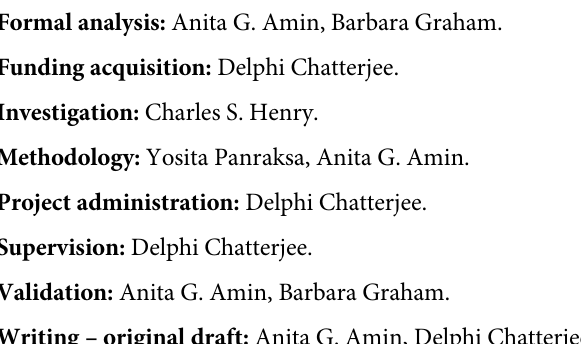
S1 Fig. Periodic acid silver staining of Mtb CDC1551 LAM. Original raw image uncropped SDS/PAGE and corresponding Western Blot. LAM purified from in vitro grown cells showing a tight smear (MW ~ 15–17 kDa). Western blot profile of the CDC1551 LAM with the anti- LAM mouse monoclonal CS35 antibody and anti-LAM human monoclonal A194, the